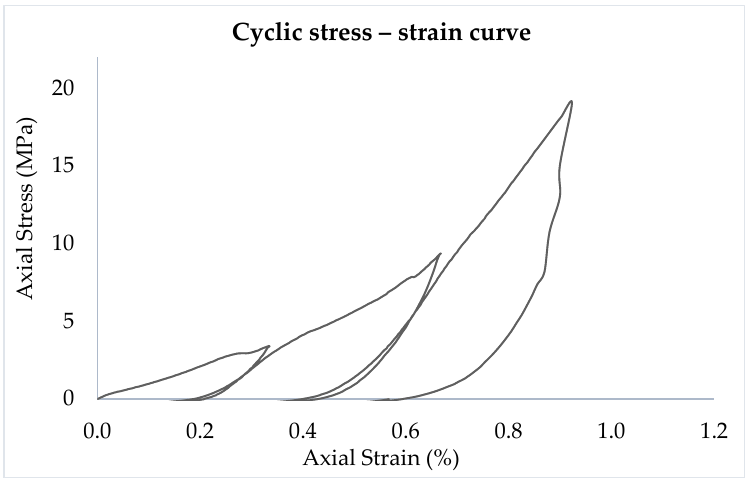
Figure 9. Axial stress versus axial strain curves of CS concrete cylinder under cyclic axial load.